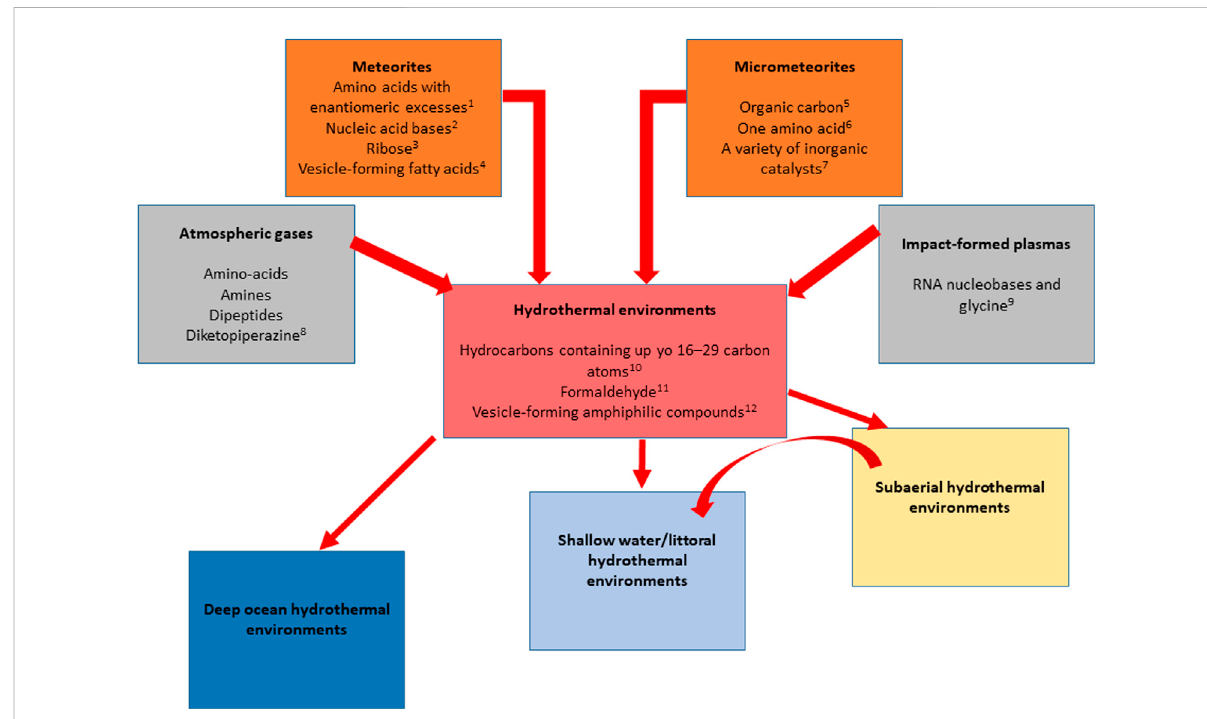
FIGURE 11 Block diagramme showing the prebiotic products arriving on, or formed on, the early Earth, and illustrating the interactions between different components and different environments. Note that there is no signi fi cant transfer of compounds between the subaerial and shallow water hydrothermal environments and those of the deep ocean; any transported molecules into the deep would be so diluted that their impact would be negligible. 1 Pizzarelloetal.(2012), 2 Stoksand Schwartz(1982), 3 Furukawa etal. (2019), 4 Deamer (1998), 5 Dobrica etal.